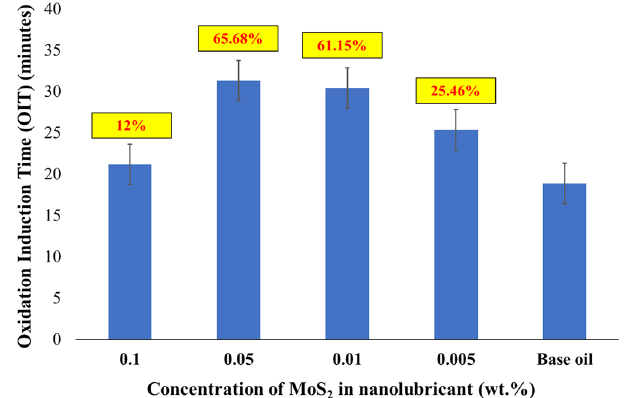
Figure 9. OIT of MoS 2 nanolubricant with different concentrations.